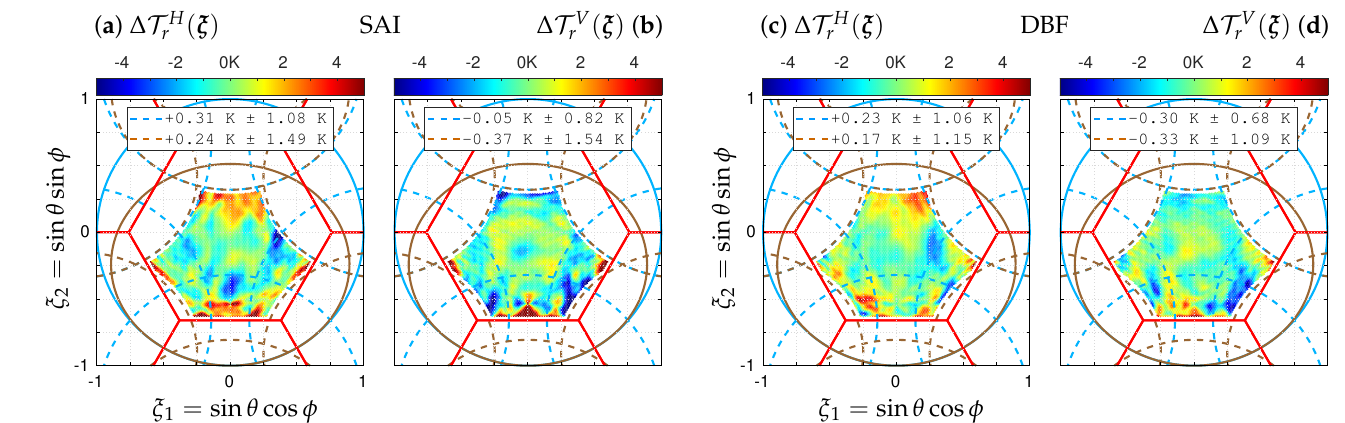
Figure 8. Floor error maps ∆ T r at ground level in H and V polarizations corresponding to ( a , b ) the inversion of complex visibilities with the SAI paradigm and to ( c , d ) the inversion of antenna temper- atures with the DBF one. Biases and standard deviations are given in the AF-FOV (dashed blue) and in the EAF-FOV (dashed brown). Color scale is the same for the four maps.